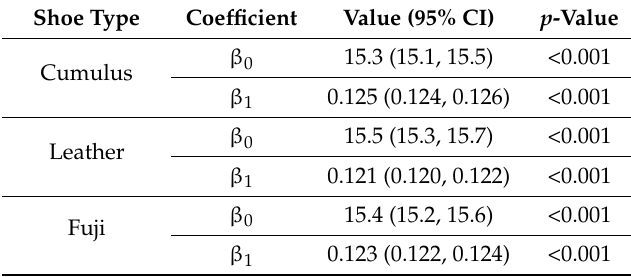
Table 1. Coefficients and associated 95% confidence intervals for the linear function mapping from pixel intensity values into temperature (Equation (1)). Values in parentheses indicate the lower and upper limit of the 95% confidence intervals for each